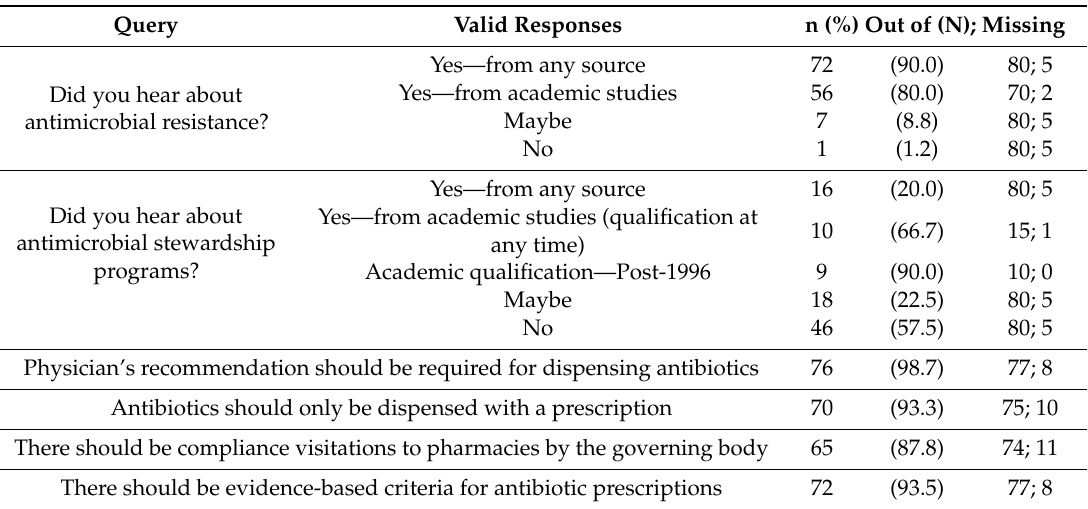
Table 2. Knowledge and attitude of Hajj deployed healthcare workers regarding regulations and uses for